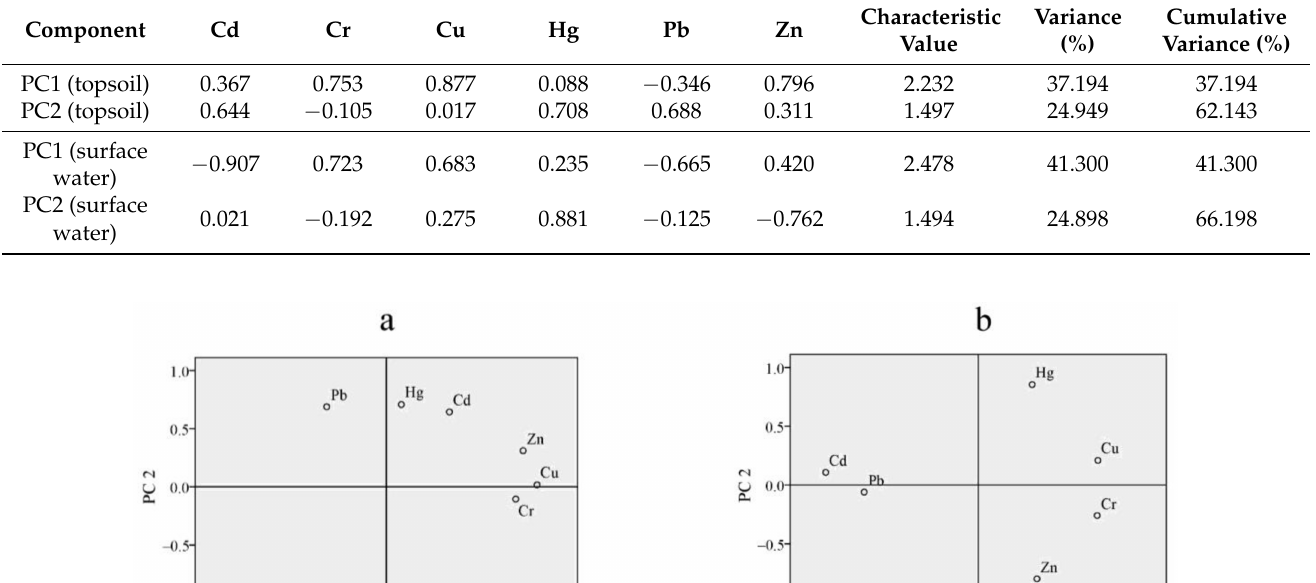
Table 11. Principal component analysis results.